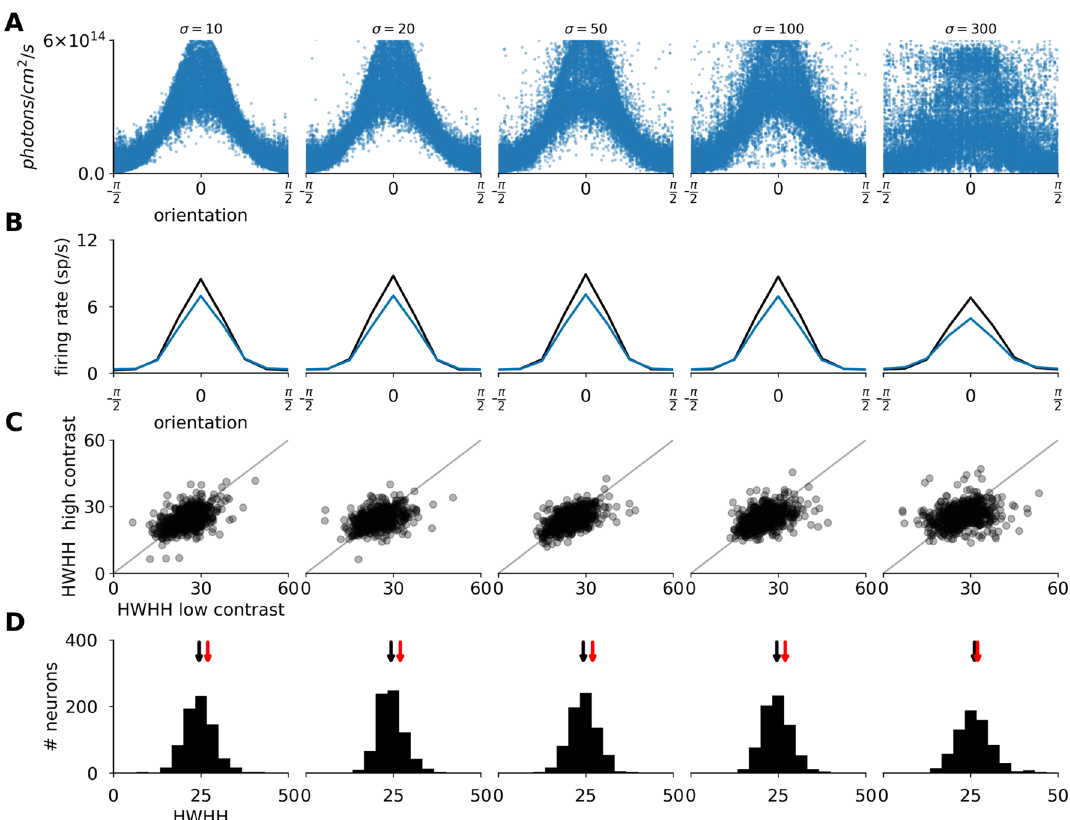
Figure 8. The impact of the diameter of individual light emitting elements (σ) on the induction of orientation tuning in V1. Each column corresponds to a cortical optogenetic stimulation with different size and pitch of light emitting elements in the OptoExc condition. ( A ) The illumination intensity at the cell body as a function of the orientation preference of the given neuron. ( B ) The orientation tuning curves centered and averaged across all recorded neurons. ( C ) The scatter plot showing the orientation tuning width measured as HWHH at low (abscissa) versus high (ordinate) contrast. ( D ) The histogram of tuning width measured as HWHH at maximum contrast. The black arrows on top mark the mean of the distribution. The red arrows mark the mean HWHH of the NatVis